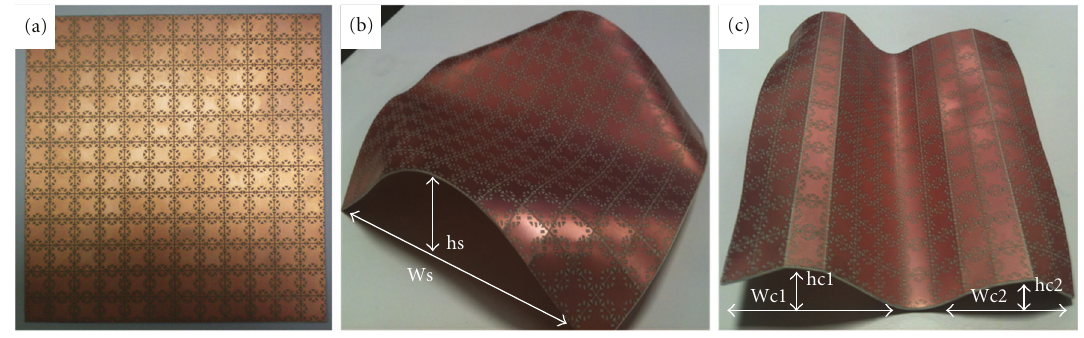
Figure 4: (a) Flat manufactured prototype and bending patters: (b) smooth prototype with Ws = 125 mm and hs = 30mm; (c) creeping prototype with Wc1 = 60mm, Wc2 = 52mm, hc1 = 18 mm, and hc2 = 15mm.